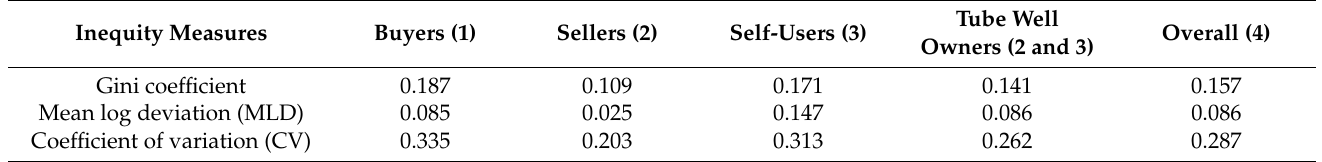
Table 5. Measures of income equality across water